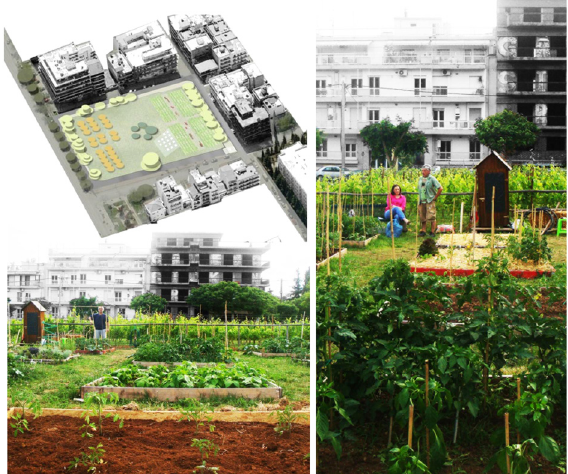
fig. 4. Intra-urban agriculture in the KIPOS 3 project in Thessaloniki,